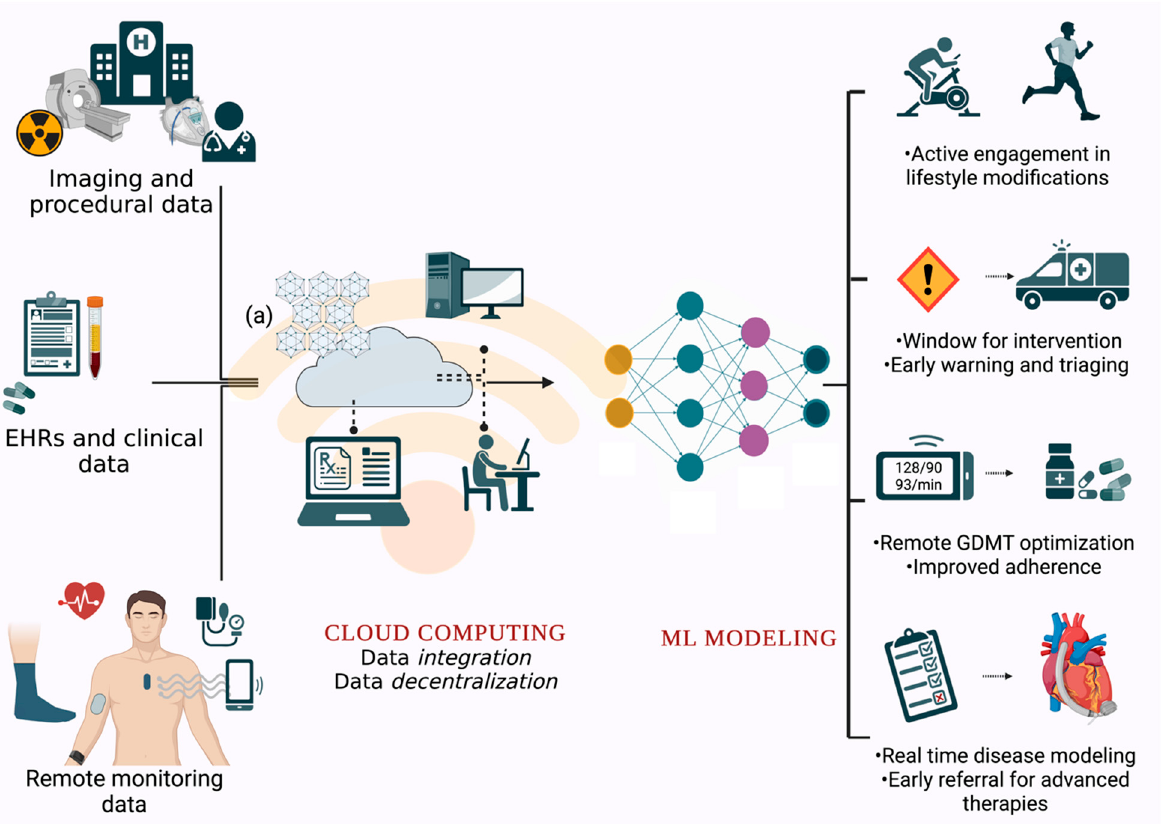
Figure 3. Remote monitoring data, along with data from EHRs and medical images stored on local computers, can be transferred to a cloud computing network, allowing for data integration. Blockchain technology (a) can allow for secure data transfers between systems and allow for data decentralization. Such pools of data, once established, can be used to train powerful ML algorithms, which can be used to guide remote interventions and identify patients needing loser follow-ups. Abbrevi-